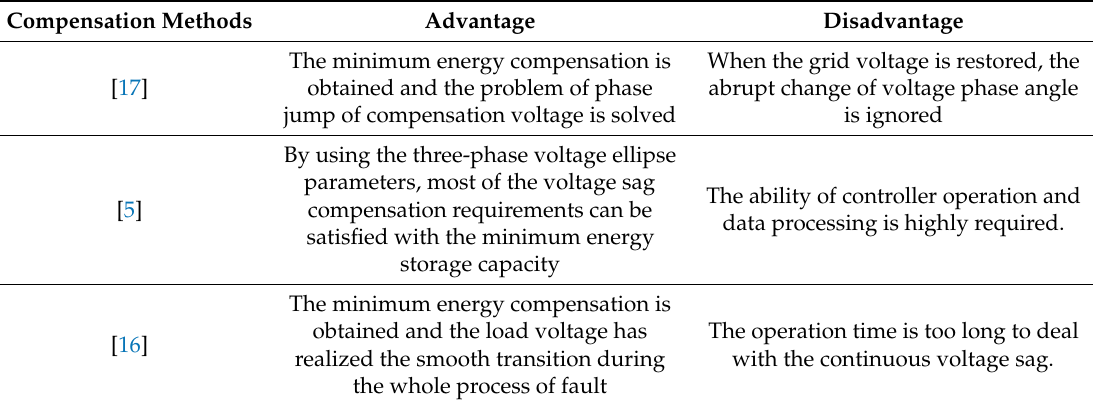
Table 2. Comparison between the other state-of-the-art compensation